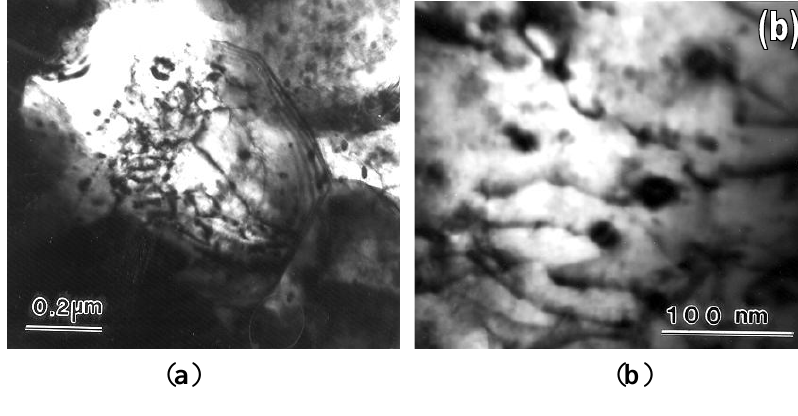
Figure 14. Transmission electronic microscopy of dispersion-bearing Zn-22% Al crept in Region I ( τ = 2.5 MPa and T = 463 K). ( a ) Low magnification microscopy showing a group of grains with the central grain containing dislocations; ( b ) High magnification weak beam microscopy showing dislocations attached to dispersion particles in the interior of a